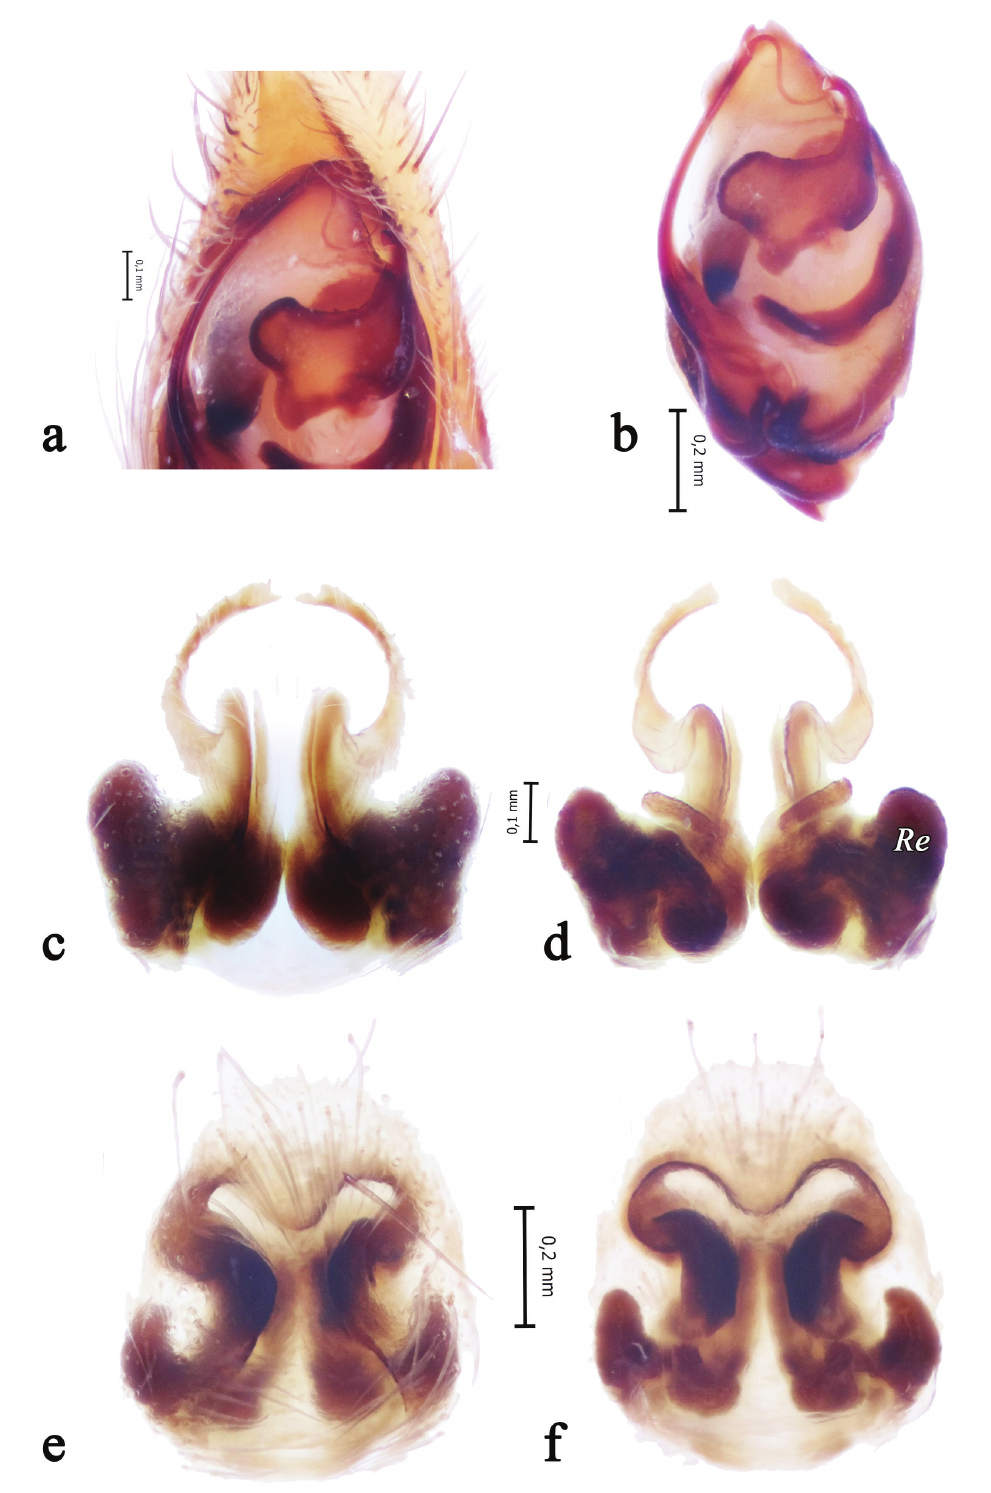
Figure 4. Copulatory organs of Pterotricha spp.: a ) apical portion of the male palp of P. arabica sp. n.; b ) dissected bulb of P. arabica sp. n.; c, d ) epigyne of P. arabica sp. n., dorsal and ventral views; e, f ) epigyne of P. cf. dalmasi , dorsal and ventral views. Abbreviation: Re :